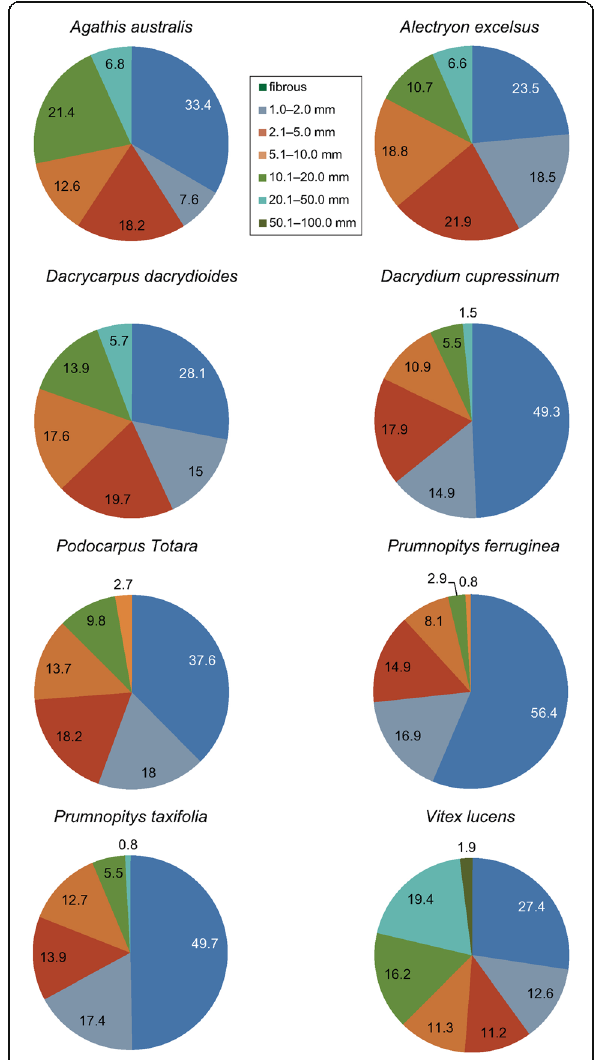
Fig. 9 Percent root biomass (%) by diameter size class (mm) of 5-year-old